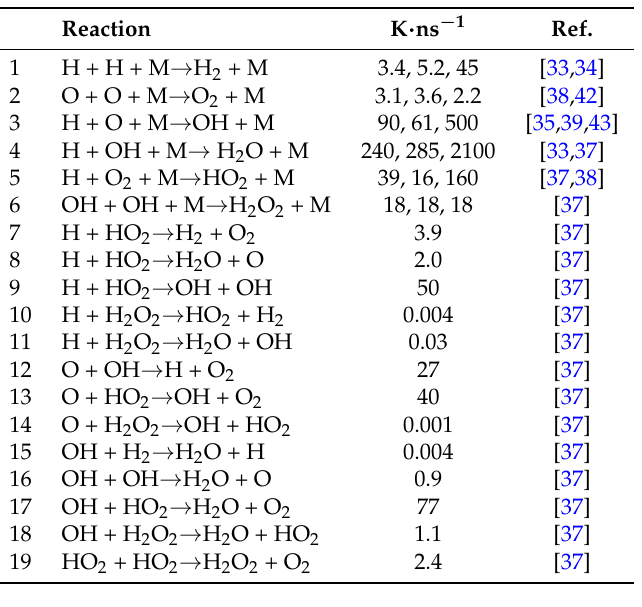
Table 1. Bulk reactions included in the network and their reaction constants calculated at T = 300 K and r = 50 nm according to (3). For termolecular reactions 1–6, the constants are given for M = H 2 , O 2 , and H 2 O,